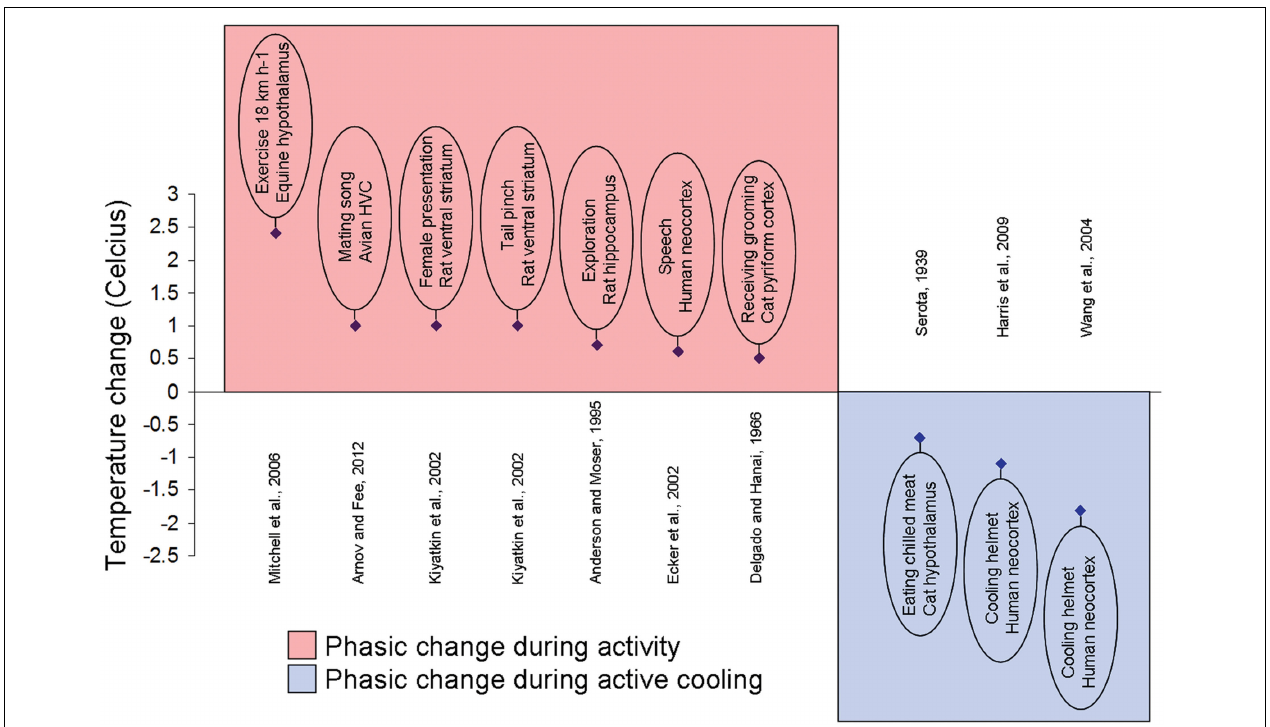
FIGURE 2 | Local brain temperature change during activity and active cooling. Example studies documenting localized phasic temperature changes after an increase in activity or a stimulus presentation (plotted over red